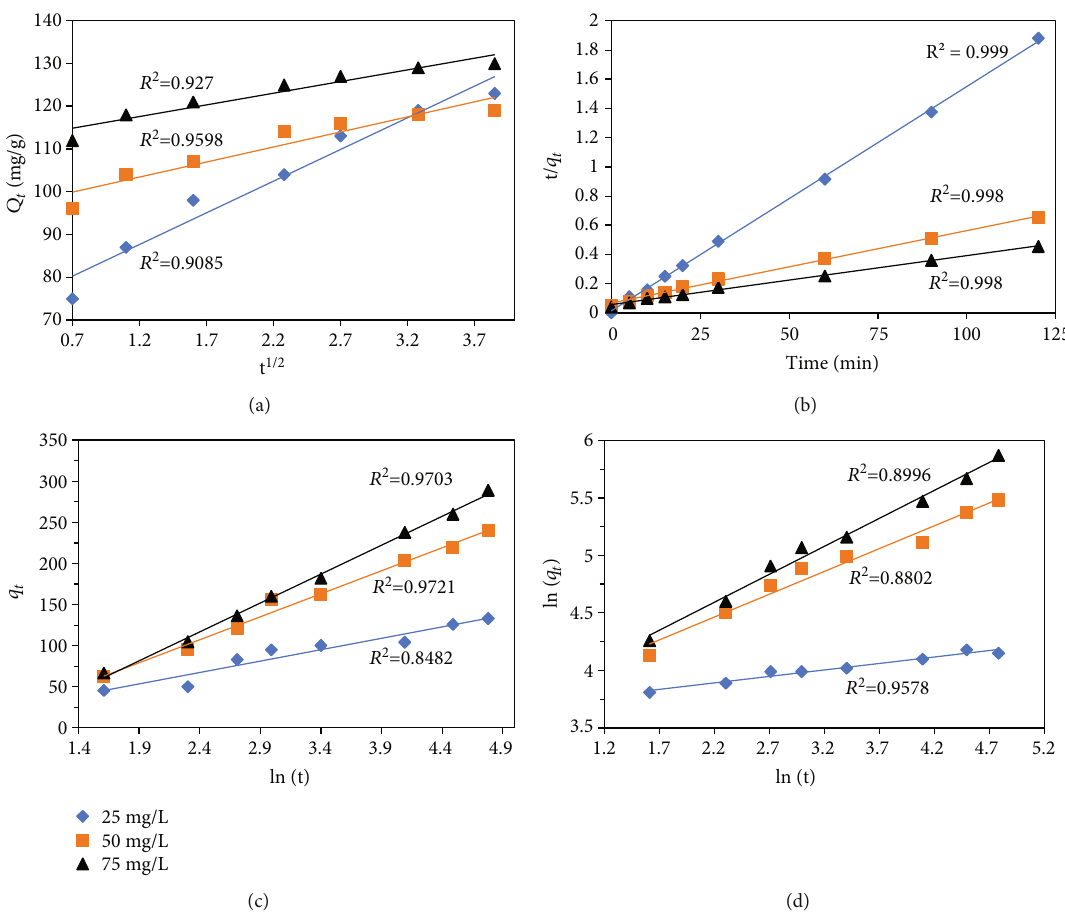
Figure 13: Plot for (a) intraparticle di ff usion model, (b) pseudo 2 nd -order rate kinetic, (c) Elovich model, and (d) modi fi ed Freundlich model ( pH = 6 : 0 , adsorbent dose = 0 : 15g/L , and time = 120 min